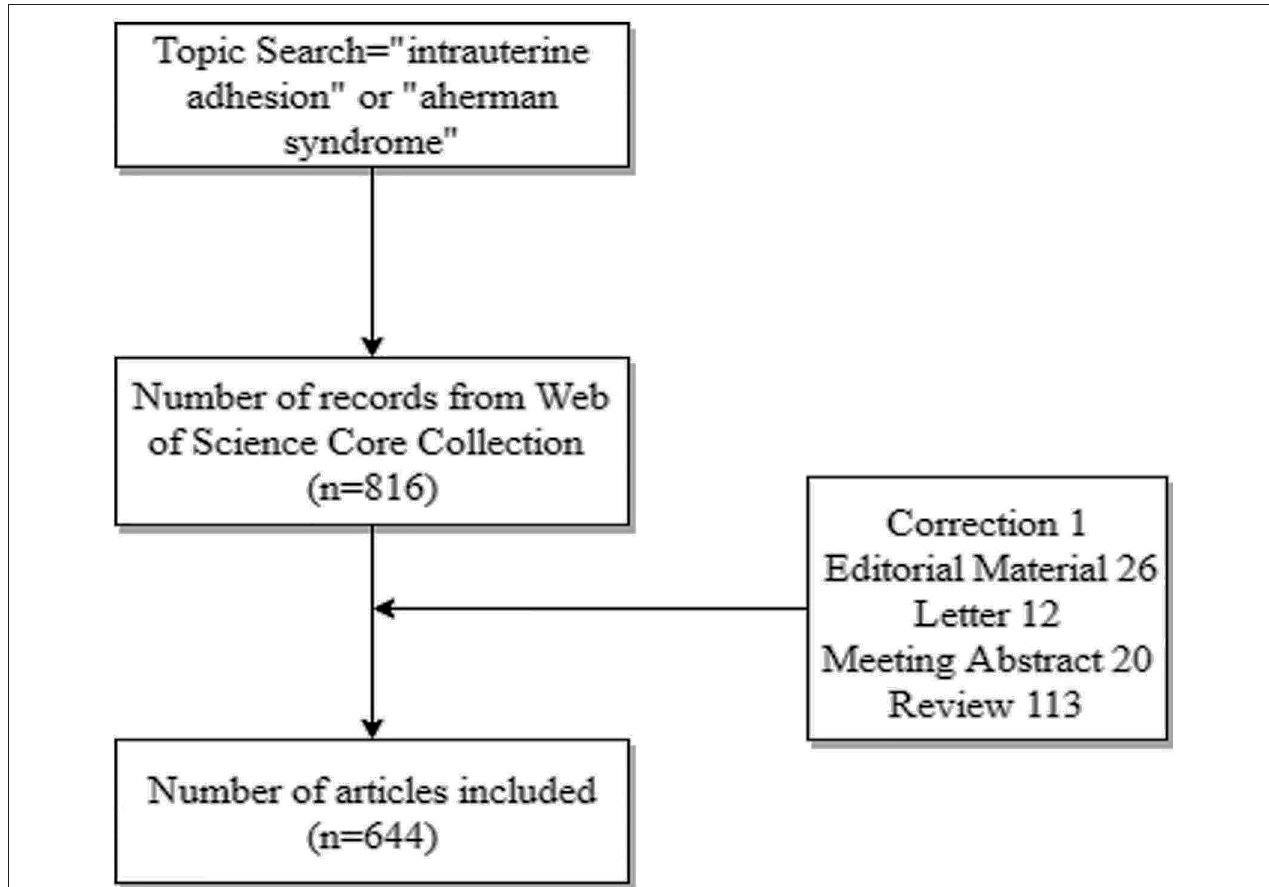
FIGURE 1 | The process of screening articles in bibliometric